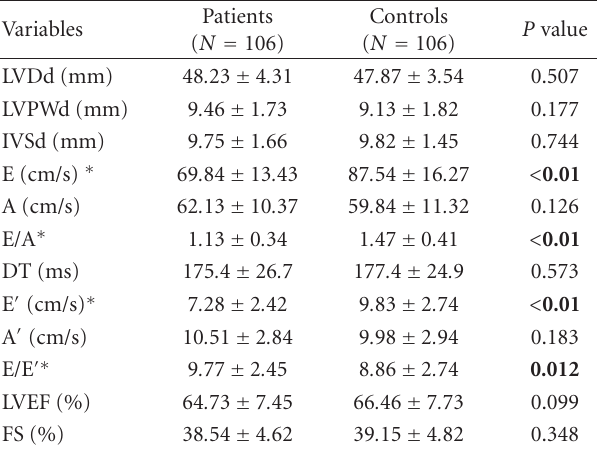
Table 4: Echocardiographic measurements between groups.